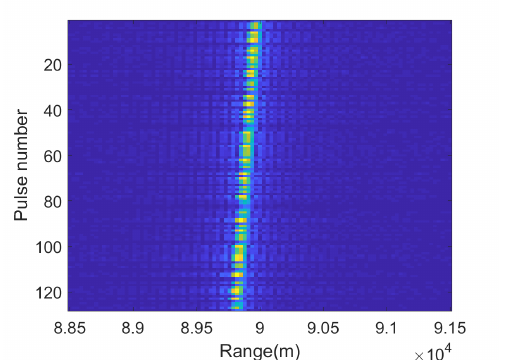
Figure 8. Range-time map after pulse compression.